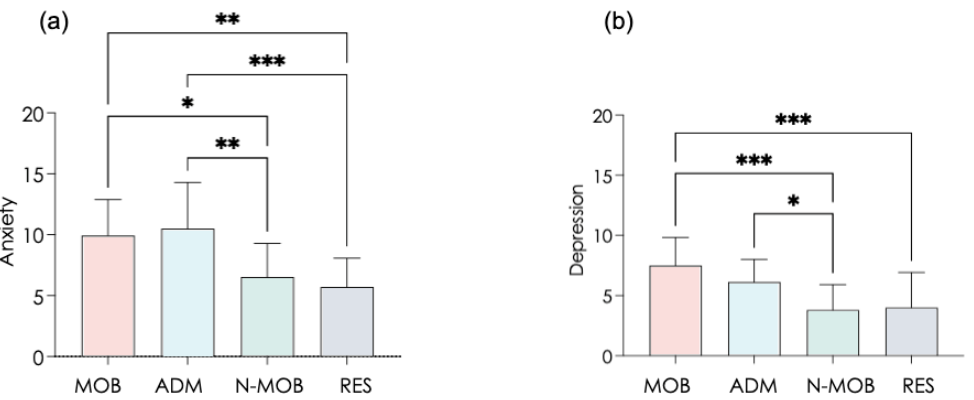
Figure 1. Scores of Anxiety subscale ( a ) and Depression subscale ( b ) calculated from the Hospital Anxiety and Depression Scale (HADS) in each tested group. MOB, mobilized healthcare workers; ADM, administrative staff; N-MOB, healthcare professionals who had not been mobilized; and RES, researchers and teachers from the University. Error bars represent the standard deviation. * p < 0.05; ** p < 0.01; *** p <